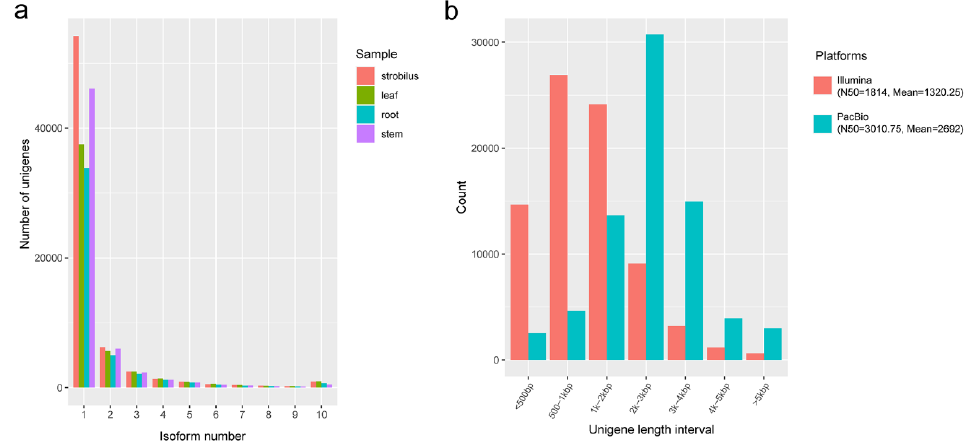
Figure 1. ( a ) Distribution of isoform numbers for unigenes in four organs of P. chienii ; ( b ) comparison of unigene length distribution using different sequencing platforms.